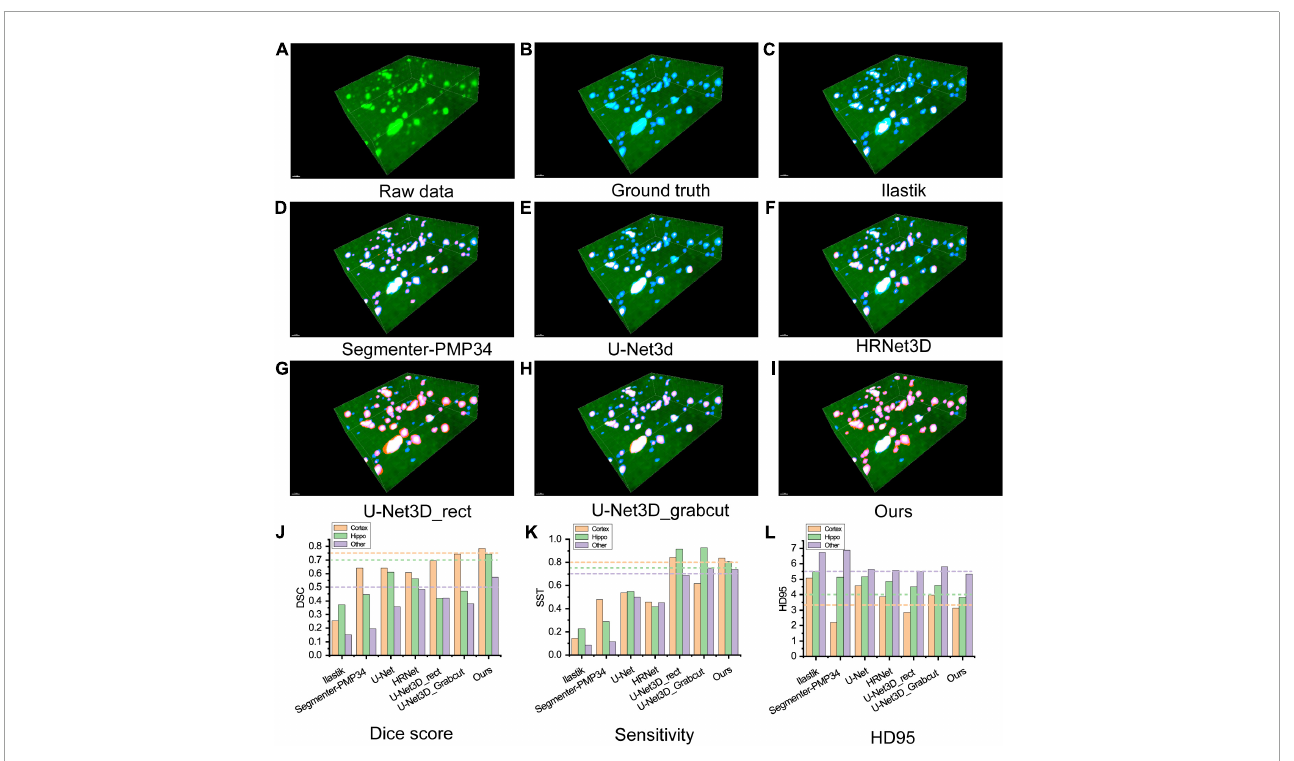
FIGURE3 (A–I) Visualization of comparing the results of different segmentation methods on an image block of test set. Green: raw image, blue: ground truth, red: segmentation result. (A) Raw image. (B) Ground truth. (C,D) Classical segmentation methods with the handcrafted label, (C) ilastik, (D) segmenter-PMP34. (E,F) Fully supervised methods, (E) U-Net3d, (F) HRNet3D. (G,H) Weakly supervised methods labeled with rectangles and Grabcuts, respectively. (I) Our method. (J–L) Metrics of segmentation performance. (J) Dice score, (K) Sensitivity, (L) HD95. Note that HD95 indicates the distance between the segmentation mask and the ground truth, lower score indicates better